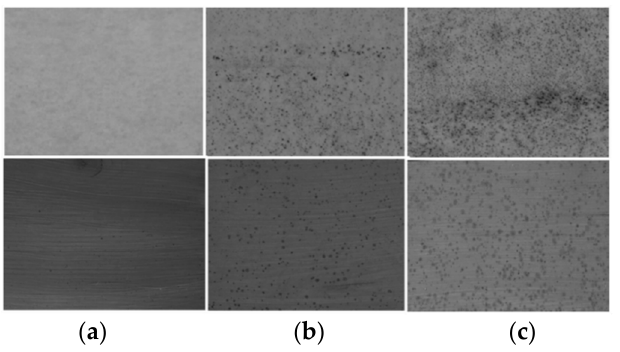
Figure 2. Mildew growth: ( a ) slight; ( b ) moderate, and; ( c ) severe mold pictures. First row corre- sponds to reference pictures [26], second row contains the mildew growing on CLT samples sur- face.